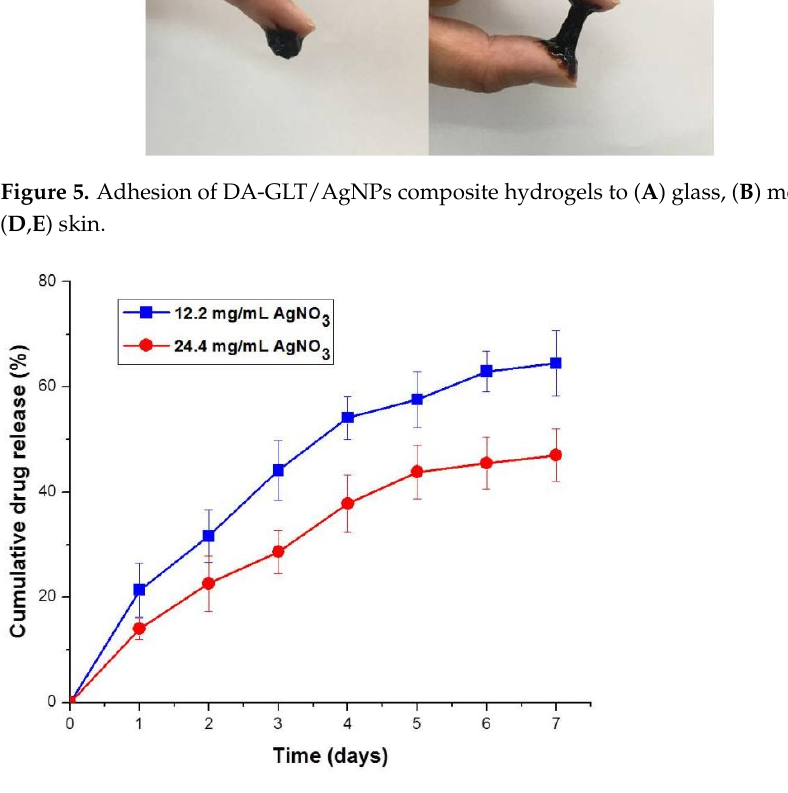
Figure 6. Cumulative drug release from DA-GLT 1 /AgNPs composite hydrogels with different feeding concentrations of AgNO 3 .